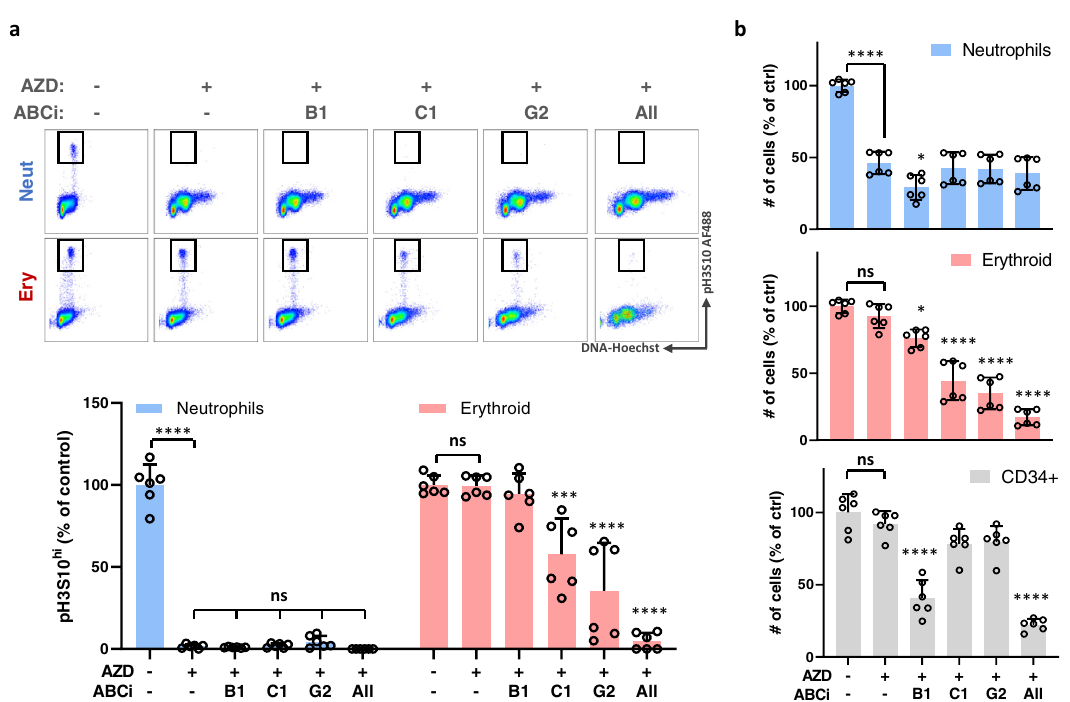
Fig. 5 | Differences in hematopoietic cell sensitivity to AZD2811 are dependent on ABC transporter function. Human CD34 + progenitor cells were cultured for 10 days and then treated for 48h with 42nM AZD2811 or vehicle control. ABC transporter inhibitors (ABCi) targeting B1 (0.5 µ M zosuquidar), C1 (50 µ M MK-571), and G2 (0.5 µ M Ko143) were also added atthe time of drug treatment asindicated. a Cells were harvested and pH3S10 was measured by fl ow cytometry. Representa- tive fl ow plots are shown along with bar graphs quantitating the percentage of pH3S10 bright cells. Meanand SD are shown; n =6, from 2 independent experiments.